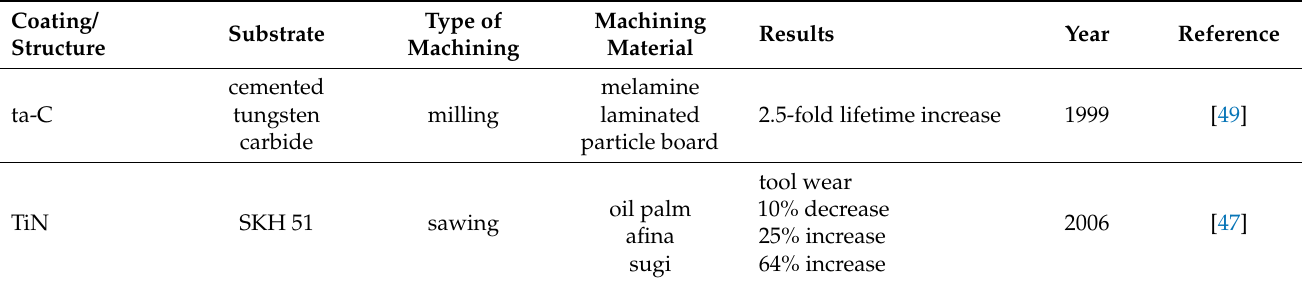
Table A3. Physical vapor deposition (PVD). Protective coatings applied to woodworking tools, synthetic information on the coatings used, the materials processed, the type of substrate and the effect of its